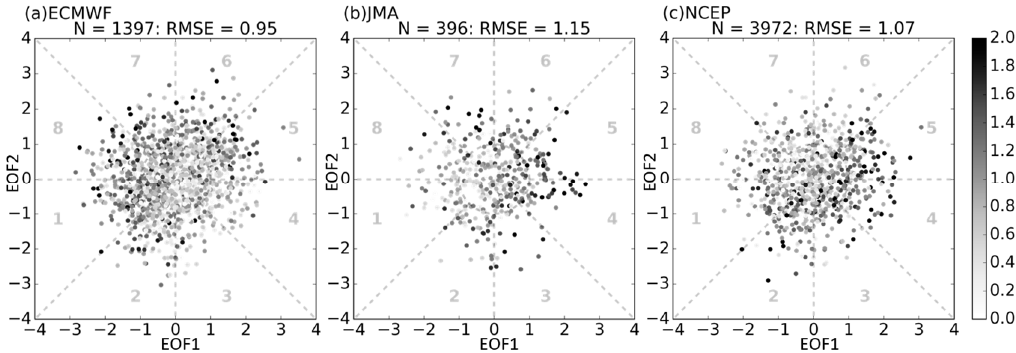
Figure 3. The prediction skill measured by a two-dimensional error vector on the Madden–Julian Oscillation (MJO) phase space for each forecast at 10-day lead time plotted at the initial-state position for ( a ) ECMWF, ( b ) JMA, and ( c ) NCEP models. The NCEP model plot is every 10 days for clarity. The magnitude of error is represented with gray scale as per the reference on the right. The MJO phases are labeled and partitioned by dashed lines in the plot. The number of forecasts and the root-mean-square error among all forecasts are provided at the top of the panels.